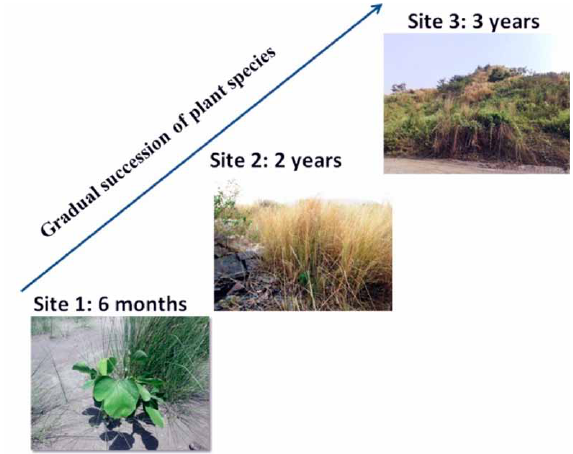
Fig. 1. Plant cover establishment in different fly ash dump